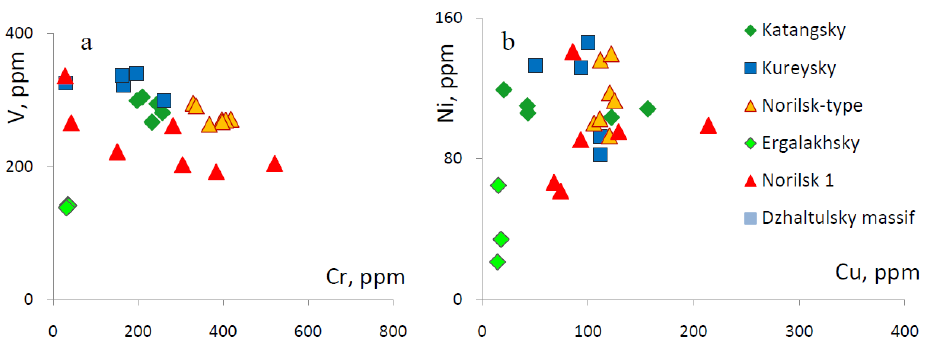
Figure 17. Diagrams Cr-V ( a ) and Cu-Ni ( b ) for intrusive rocks.